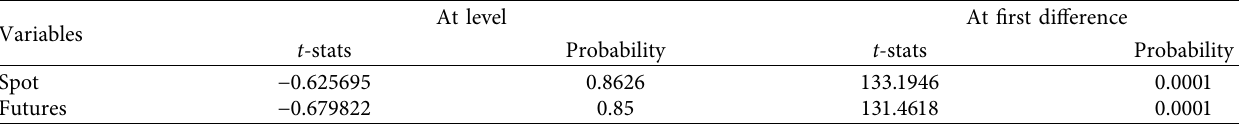
Table 3: unit root test.